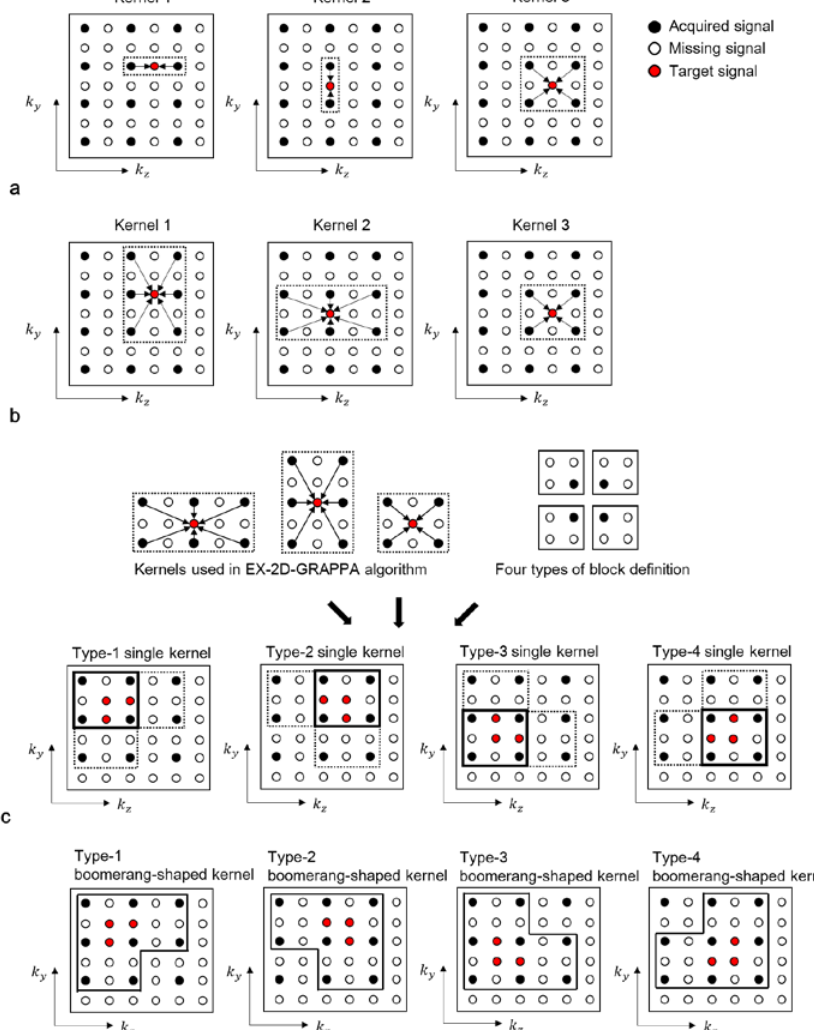
Figure 3. Schematic diagrams of LK-2D-GRAPPA, EX-2D-GRAPPA, SK-2D-GRAPPA and BK-2D- GRAPPA algorithms with basis kernels. ( a ) The basis kernels of the LK-2D-GRAPPA algorithm are two 1D kernels and a 2D kernel, which use acquired data points in each PE direction and k y - k z plane, respectively. ( b ) The EX-2D-GRAPPA algorithm utilizes three types of 2D kernels; two of them are extended from the LK-2D-GRAPPA algorithm. ( c ) A single square kernel is created with the common acquired data points utilized with the kernels of the EX-2D-GRAPPA algorithm. ( d ) A boomerang kernel is produced with all the acquired data points used with the kernels of the EX-2D-GRAPPA